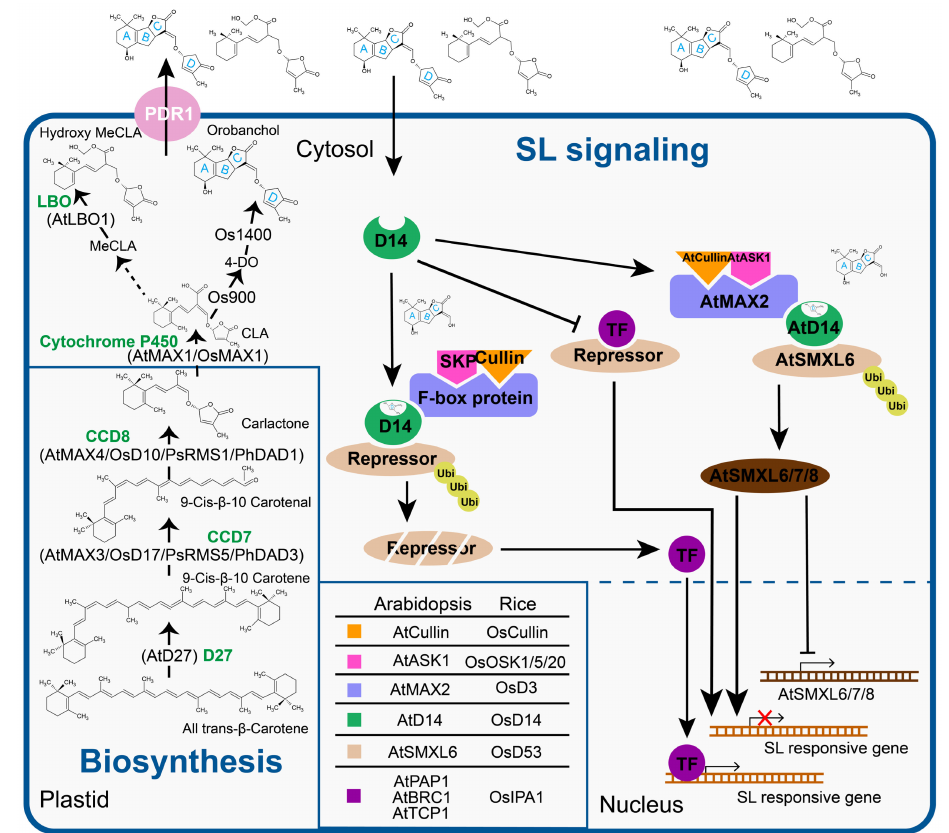
Figure 1. The proposed SL biosynthetic pathway. SLs are derived from the carotenoid pathway, branching out from 9- cis - β -10 carotene by the action of iron-binding carotenoid isomerase DWARF27 ( D27 ) in rice or AtD27 to generate 9- cis - β -10 carotene. The carotenoid cleavage dioxygenase 7 ( CCD7 ), which is encoded by Arabidopsis More Axillary Growth3 ( AtMAX3 ), rice D17 / HTD1 or pea Ramosus ( RMS )5, and petunia Decreased Apical Dominance ( DAD )3, catalyzes 9- cis - β -10 carotene into 9- cis - β -10 carotenal. CCD8 , encoded by AtMAX4/D10/RMS1/DAD1 , then converts 9- cis - β -10 carotenal into carlactone. In Arabidopsis, MAX1 converts carlactone into MeCLA and lateral branching oxidoreductase (LBO) converts the MAX1 -derived MeCLA (methyl carlactonoate) carlactonoic acid (CLA) that is subsequently converted to methyl carlactonoate (MeCLA) by the unidentified methyl transferase, and finally lateral branching oxidoreductase (LBO) converts the MAX1 -derived MeCLA into hydroxy methyl carlactonoate (OH-MeCLA), whereas in rice, MAX1 / CYP711A2 converts CLA that is then converted to 4-deoxystrigol (4-DO) by CYP711A2 (Os900), and finally CYP711A3 (Os1400) further catalyzes 4-DO to yield orobanchol. Bioactive SLs are perceived by the α / β -fold protein D14 acting as an SL receptor. D14 interacts with D3 / AtMAX2 to form the D14-SCF D3/AtMAX2 ubiquitination complex, through which the SL signaling repressor D53/SMXL6,7,8 was degraded by a 26S proteosome